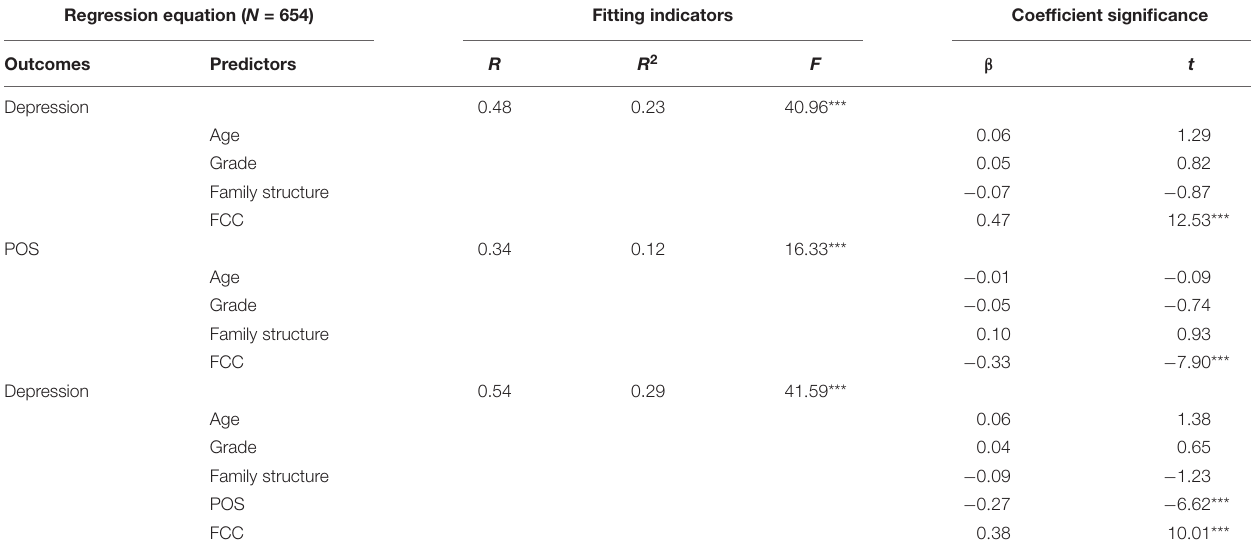
TABLE 3 | Results for the mediation effect of POS. Regression equation ( N = 654) Fitting